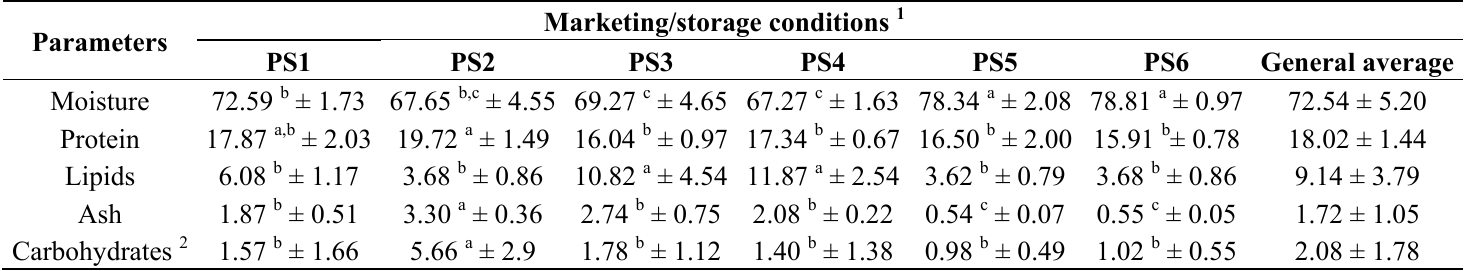
Table 2. Physicochemical quality (g/100 g) of goat “sarapatel” marketed under different storage